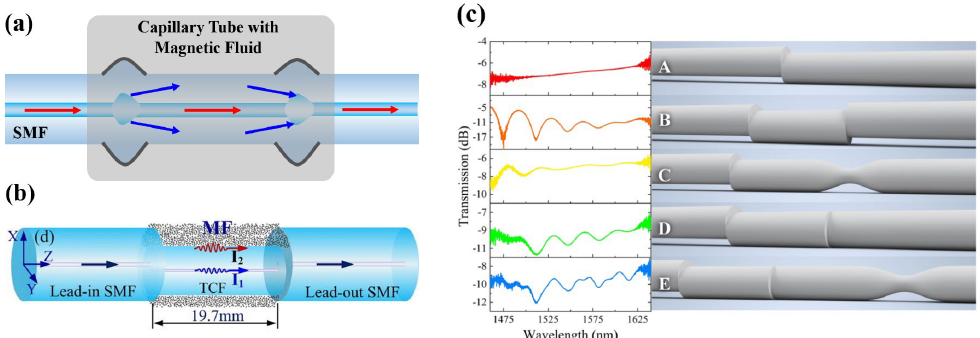
Figure 2. Magnetic field fiber sensors based on ( a ) the up-tapered structure [30], ( b ) the offset-core structure (reprinted with permission from Ref. [35], 2017, Elsevier). ( c ) Some offset–core structures and interference spectrums (reprinted with permission from Ref. [36], 2021, The Optical Society).